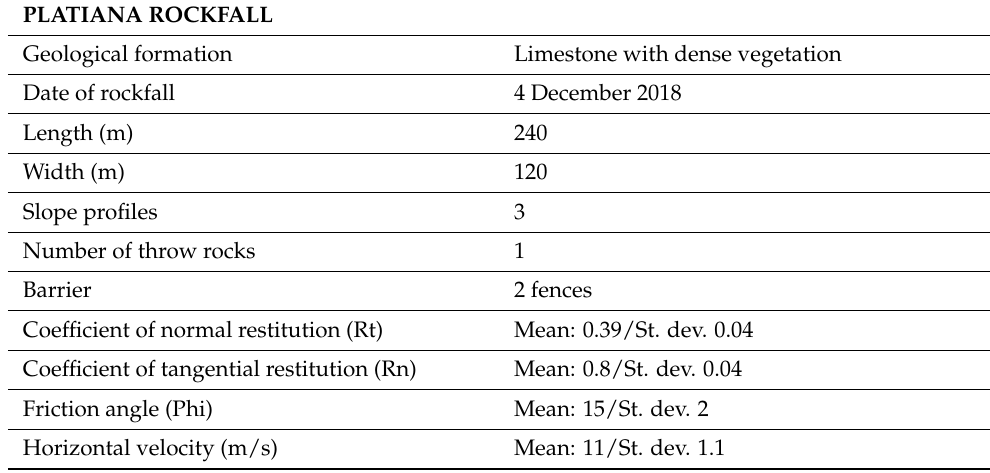
Table 4. Geological and material